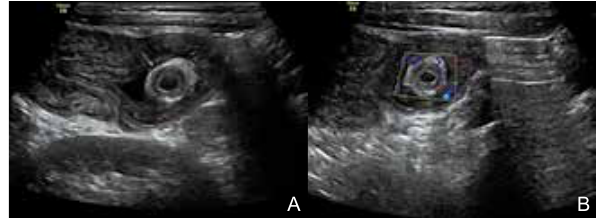
the neck of the intussusception (arrow) showing a polyp (arrow); (C ) CDFI revealed dot-like and stripe-like signals of blood flow within the hypoechoic mass.